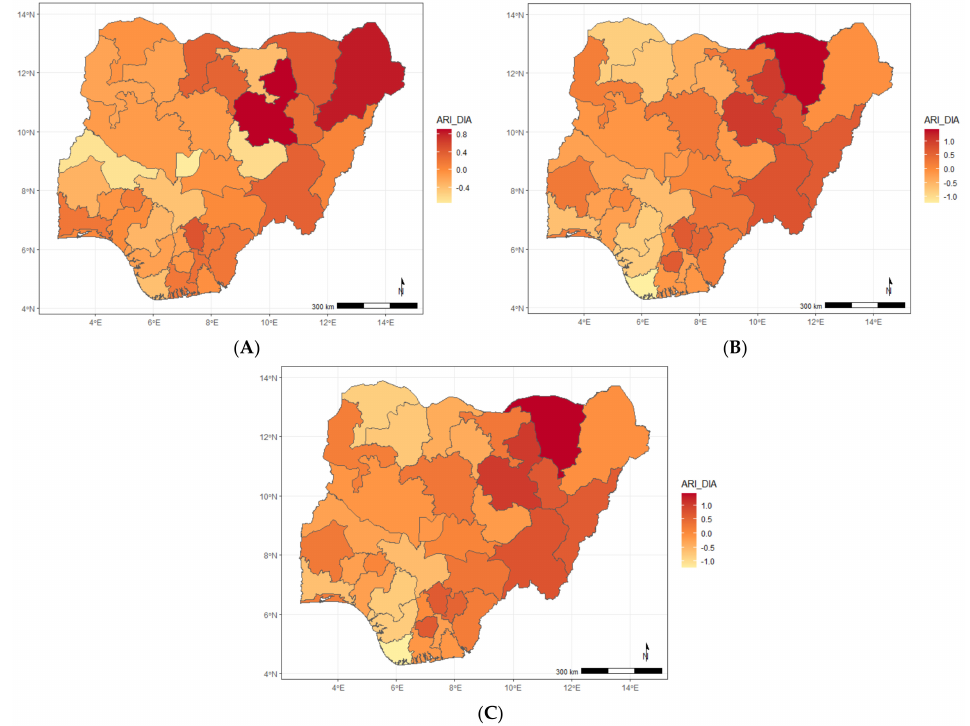
Figure A4. Maps showing posterior estimates of the ARI and diarrhoea spatial shared effect by year of NDHS implementation; ( A ) 2008, ( B ) 2013, ( C )